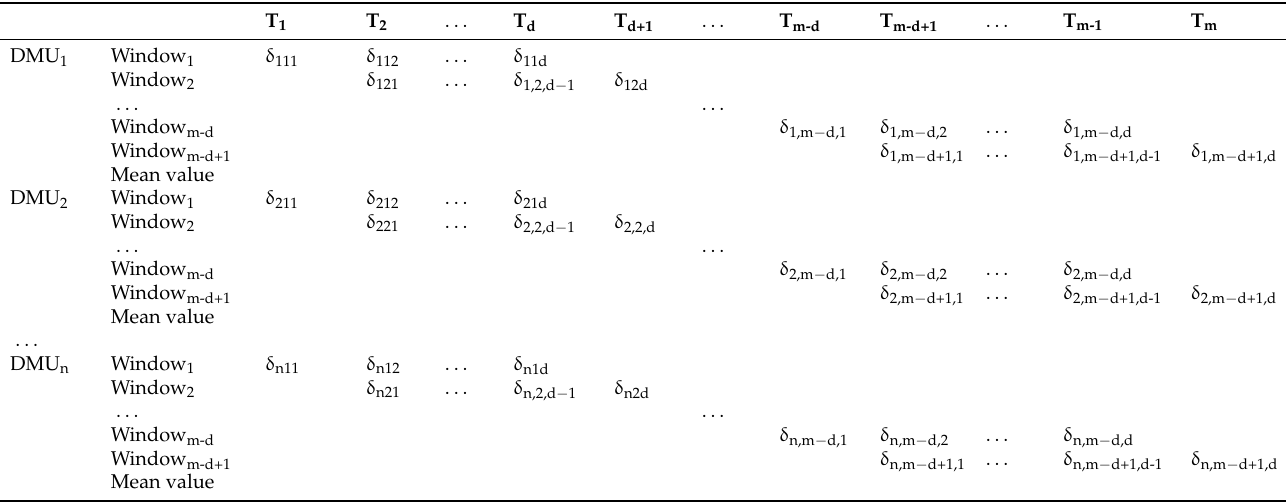
Table 6. The basic principle of DEA moving split-windows